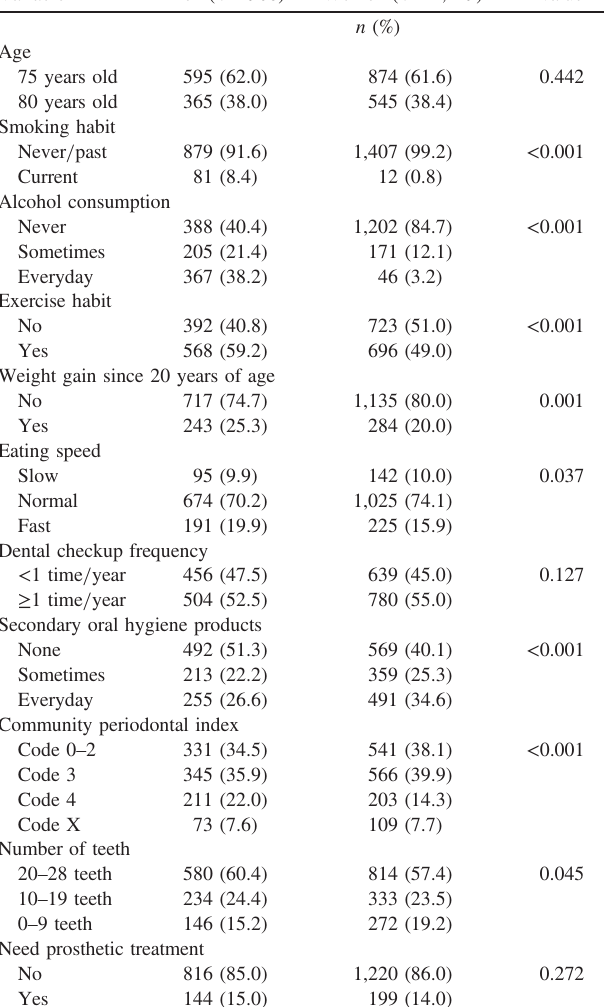
Table 1. Characteristics of the study participants according to